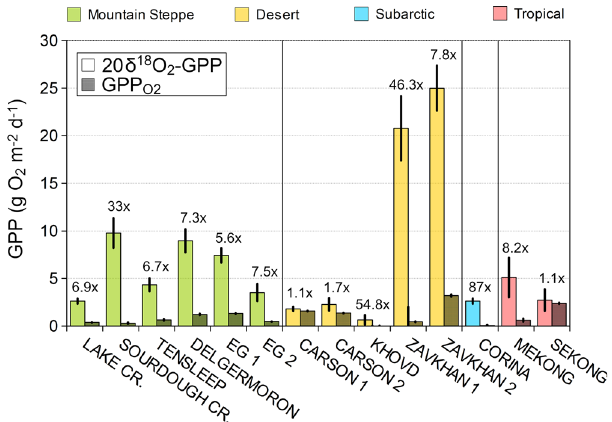
Fig. 5 Temperature normalized (20 °C) diel rates of primary production 20 δ 18 O 2 -GPP from dual δ 18 O 2 and O 2 model compared to diel GPP O2 rates from O 2 – only model. 20 δ 18 O 2 -GPP rates from dual δ 18 O 2 and O 2 model (solid bars) rates compared to GPP O2 (patterned bars) estimated with O 2 — only metabolism models. Labels indicate the magnitude of the difference between 20 δ 18 O 2 -GPP and GPP O2 for each site. Black bars indicate ±1 SD of posterior model O 2 :CO 2 is high, and this is accentuated at high light 31 and higher